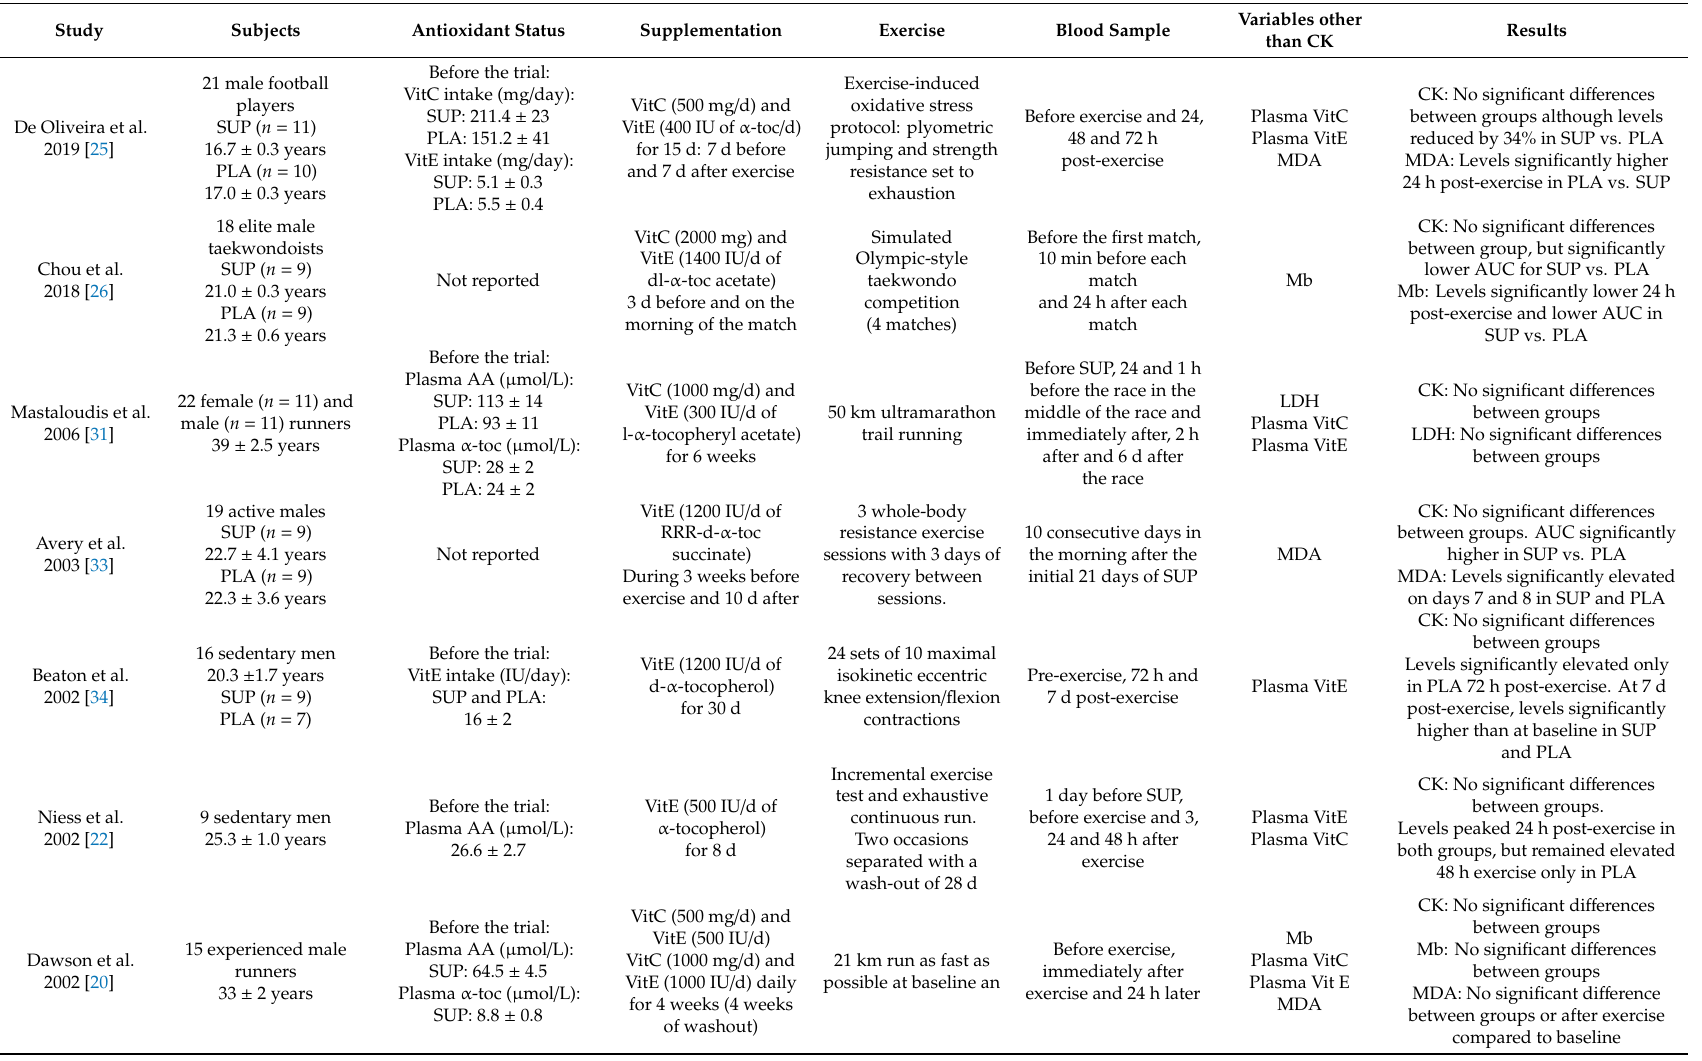
Table 3. Summary of studies reviewed examining the e ff ects of chronic supplementation with VitC and / or VitE in one session or several sessions per week of exercise.